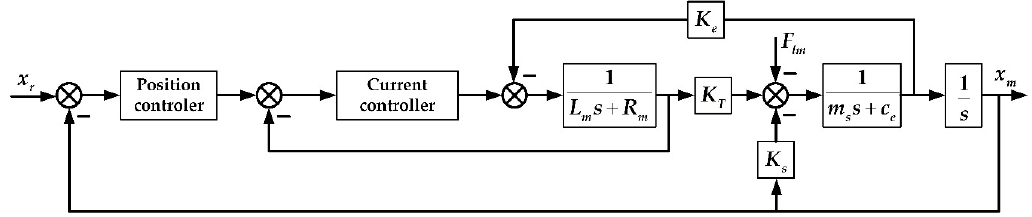
Figure 9. Cascaded control of the linear oscillating motor.